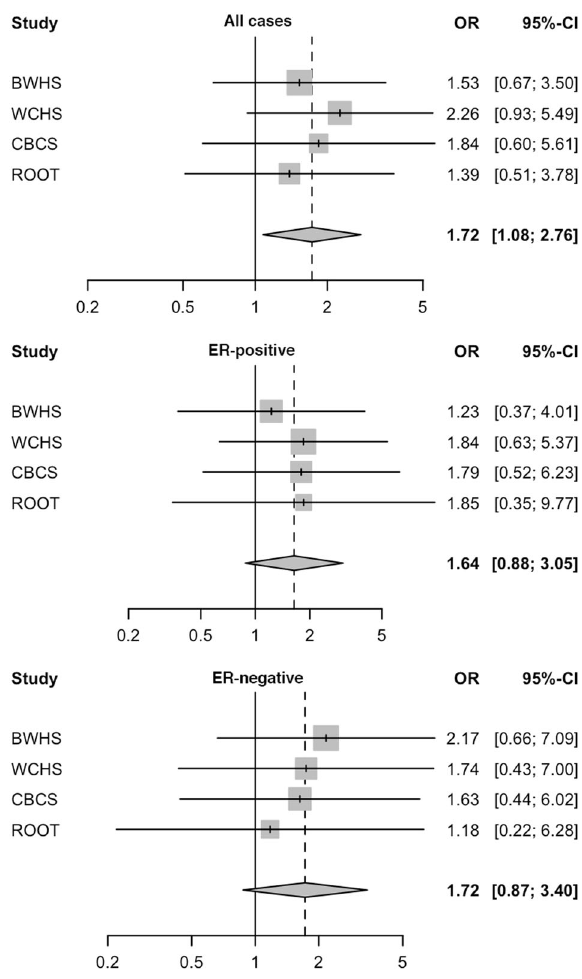
Fig. 1 Forest plot of meta-analysis of TP53 rs1800371 with breast cancer risk among pre-menopausal women in the AMBER and ROOT consortia. Study-speci fi c odds ratios (OR) from each of BWHS, WCHS, CBCS, and ROOT is indicated as a shaded square , with 95% con fi dence interval (CI) shown as a horizontal line . The meta-OR is indicated as a diamond , with the width corresponding to the 95% CI. The analyses were performed for all cases, ER-positive cancer, and ER-negative